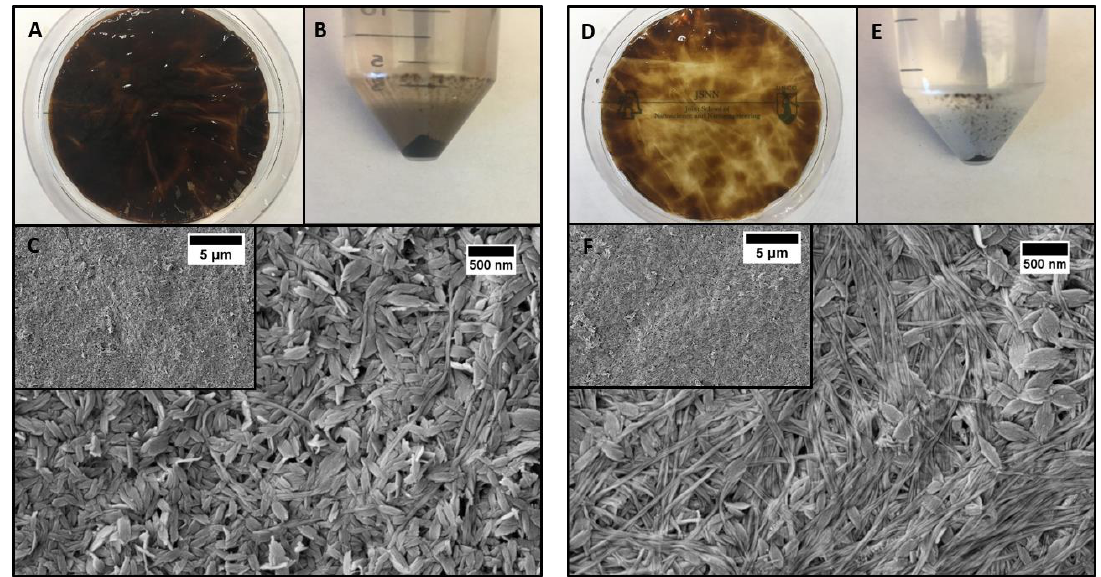
Figure 4. Removal of non-adsorbed CuSO 4 via thorough rinsing: ( A–C ) BC – CuO with no rinse after 1 hr in 50 mM CuSO 4 (no rinse after step 1); ( A ) Picture of BC – CuO, ( B ) Picture of pellet after centrifugation of step 3 reaction solution at ~1750 RCF for 10 min, ( C ) SEM of BC – CuO. ( D–F ) BC – CuO with thorough rinsing after 1 hr in 50 mM CuSO 4 (with rinse after step 1); ( D ) Picture of BC – CuO, ( E ) Picture of pellet after centrifugation of step 3 reaction solution at ~1750 RCF for 10 min, ( F ) SEM of BC – CuO.